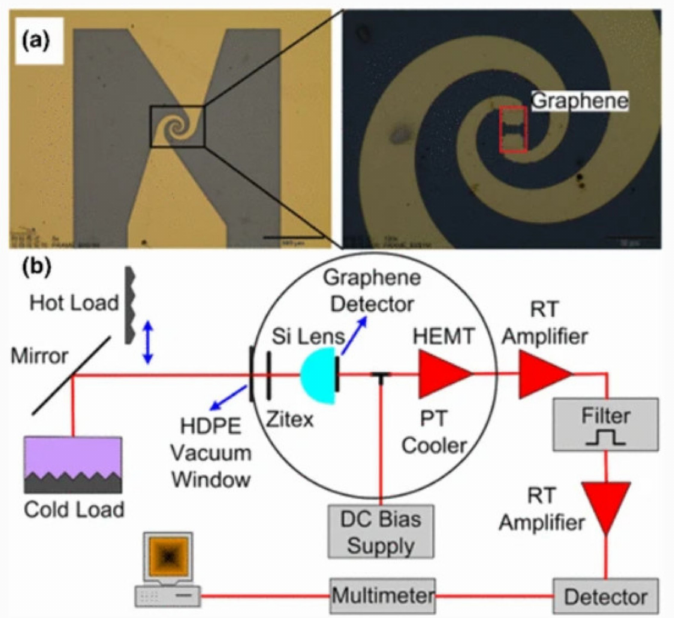
Figure 3. ( a ) Image of the graphene-based thermal noise readout bolometer. ( b ) The schematic illustration of the measurement system. Reprinted with permission from ref. [66]. Copyright 2021 Copyright Clearance